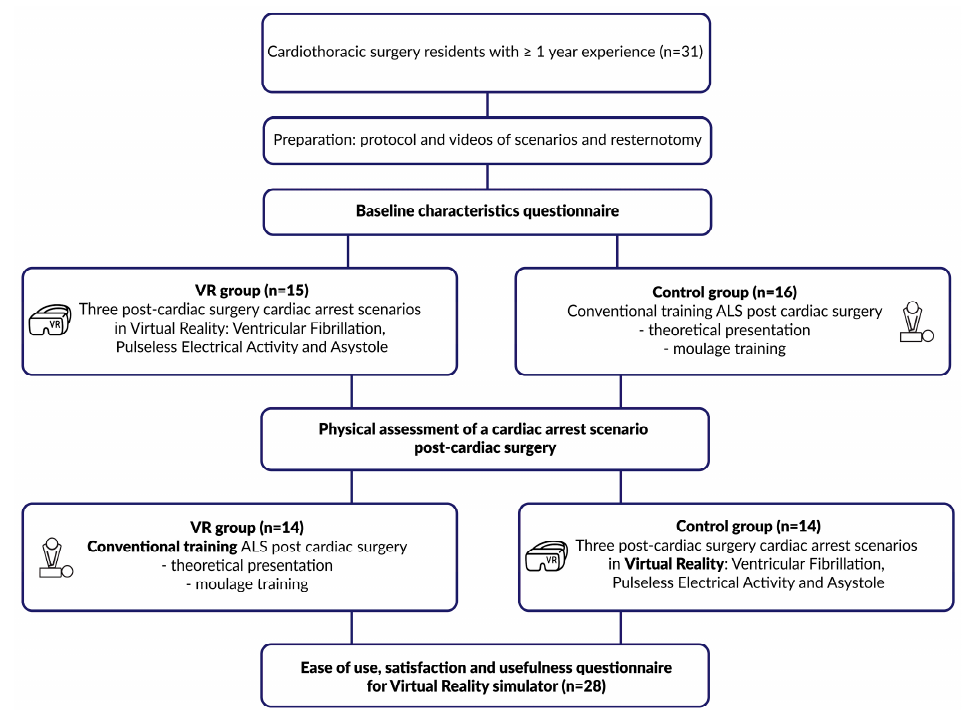
Figure 2. Flowchart of the study design of this randomized control trial.